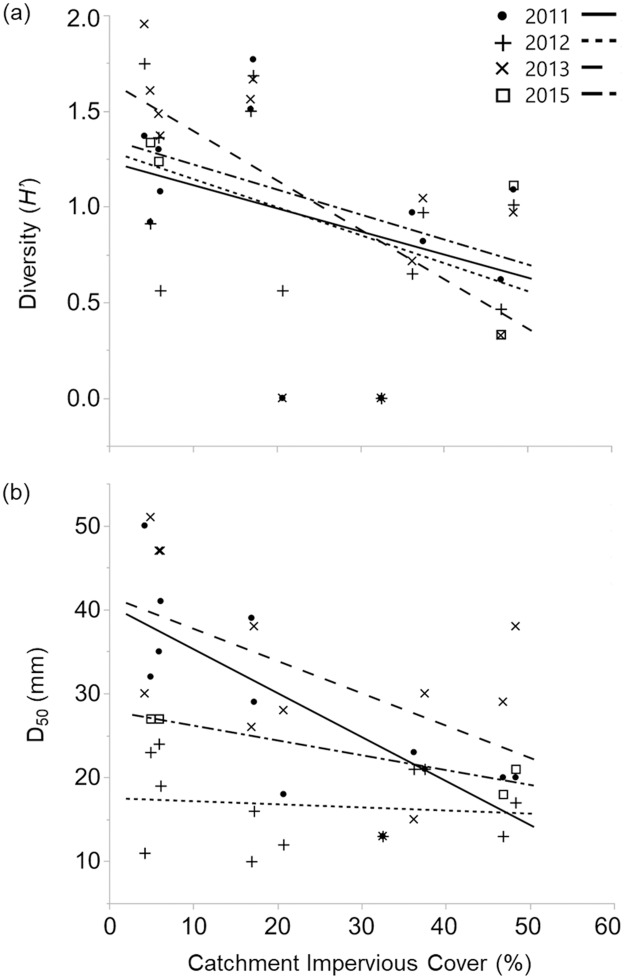
Linear relationships between % catchment imperviousness and Δ fish assemblage and hydrogeomorphic variables.Linear relationships by year between % catchment imperviousness and (a) diversity (H’; 2011: R2 = 0.14, F = 1.57, p = 0.239; 2012: R2 = 0.20, F = 2.56, p = 0.141; 2013: R2 = 0.41, F = 6.96, p = 0.025; 2015: R2 = 0.48, F = 1.88, p = 0.304) and (b) D50 (2011: R2 = 0.61, F = 15.33, p = 0.003; 2012: R2 = 0.02, F = 0.16, p = 0.699; 2013: R2 = 0.28, F = 3.87, p = 0.077; 2015: R2 = 0.91, F = 20.72, p = 0.045).